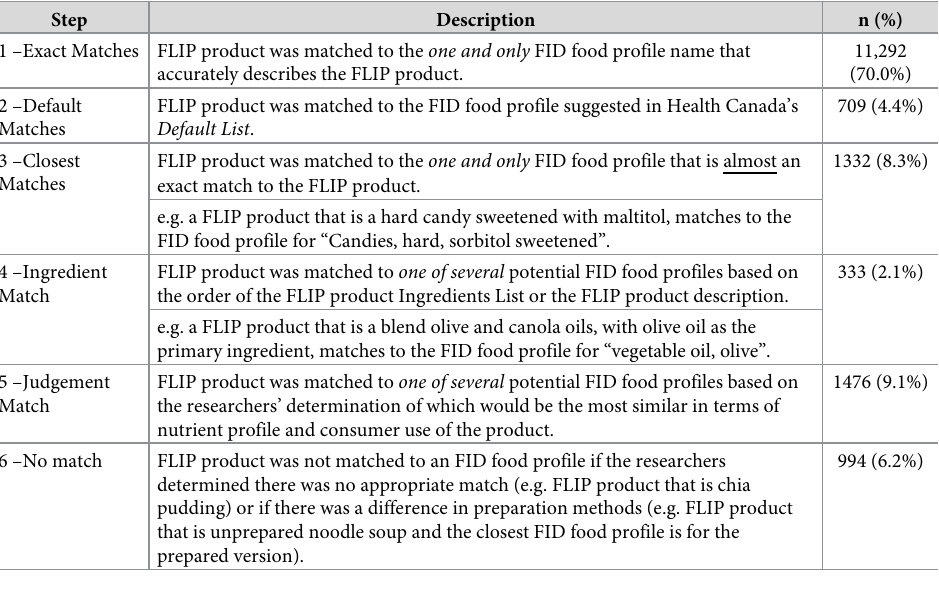
Table 1. Step-by-step method for determining which FID food profile was most appropriate to match with each FLIP product and the number and percent (%) of foods matched at each step (n = 16,136) a . Step